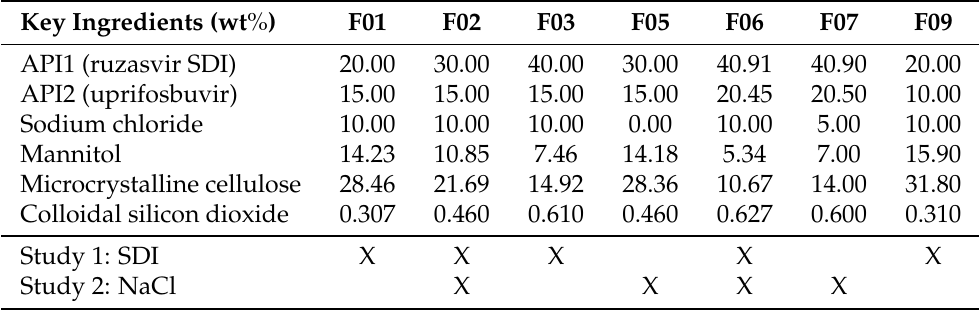
Table 1. Tablet formulations. In addition to the listed ingredients all formulations contain croscarmel-